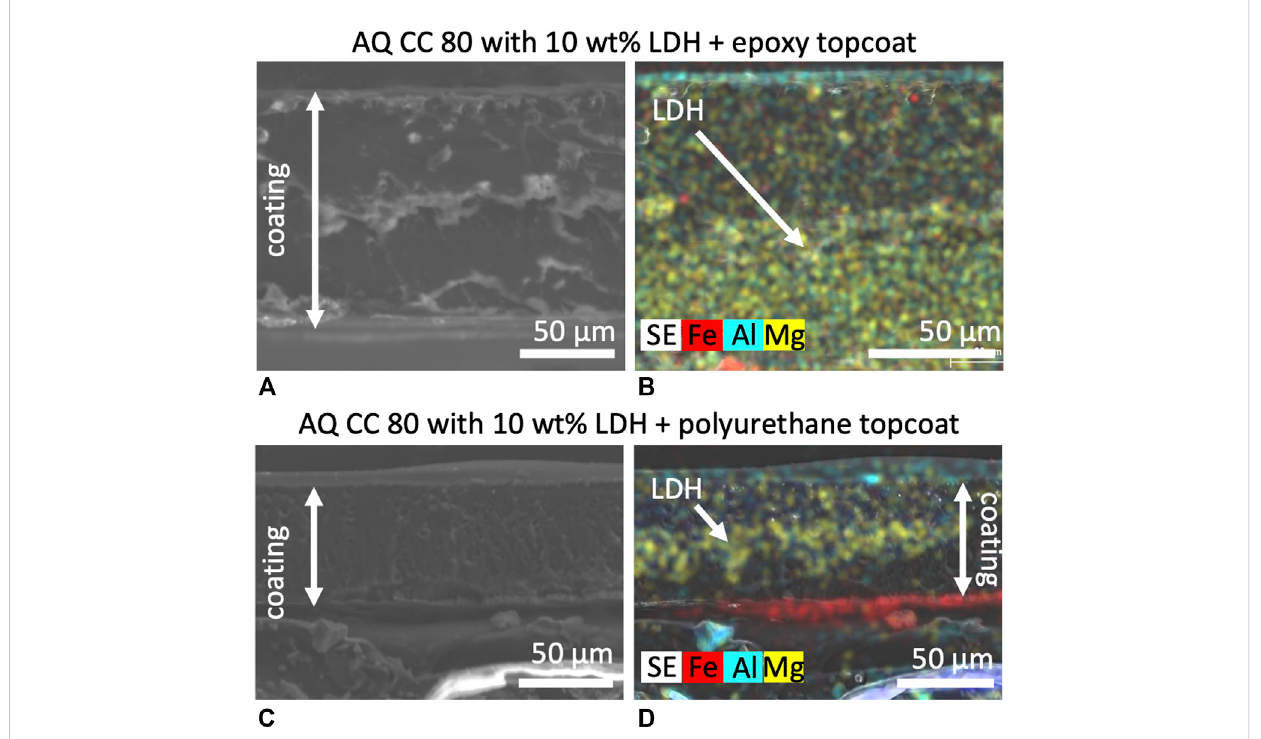
FIGURE 11 SEMimaging (A,C) andEDSmapping (B,D) ofthemultilayercoatingsystemswithMg-Al/[Fe(CN) 6 ]LDHsensingnanoadditive: multilayersystem1 (A, B) and multilayer system 2 (C, D)